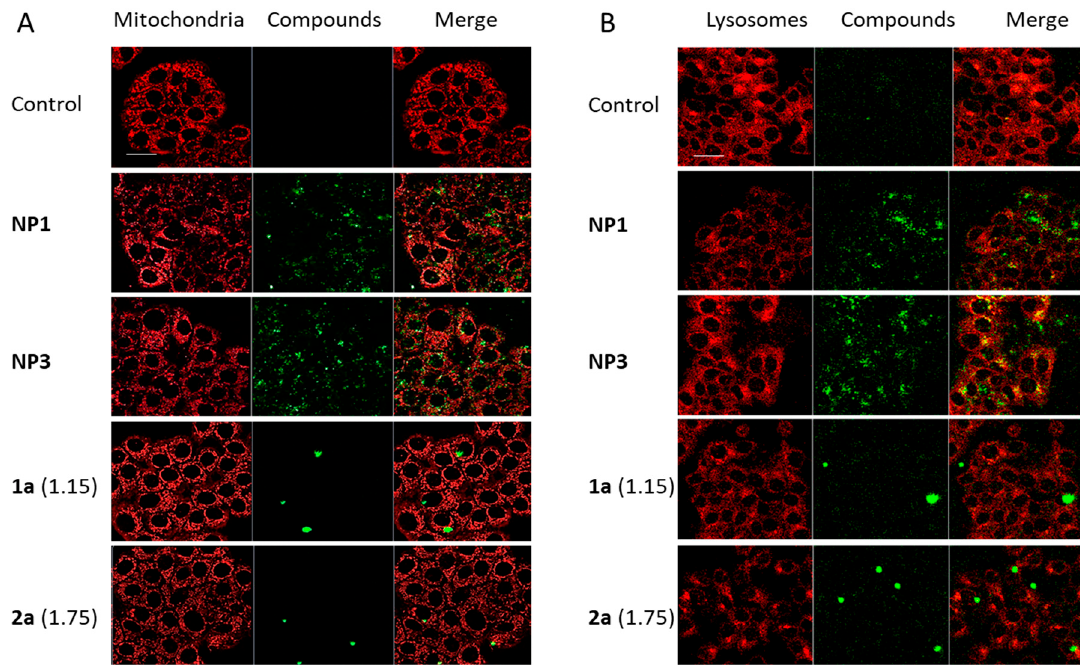
Figure 6. Colocalization experiments. MCF-7 breast cancer cells incubated for 20 h with NP1 and NP3 (25 µg·mL − 1 ) and with analogous TEG-ylated 1a and 2a at the same porphyrin concentrations. NPs and free porphyrins were excited with a Chameleon femtosecond laser ( λ ex = 790 nm) and appear here in green. Mitochondria ( A ) or lysosomes ( B ) were stained with MitoTracker ( λ ex = 490 nm) or LysoTracker ( λ ex = 577 nm), respectively and appear here in red. Scale bar: 10 µm. Finally, and in order to verify the possible use of such NPs with other cancer cells, their internalization was studied on highly aggressive cell lines such as MDA-MB-231 breast cancer (triple negative) and Capan-1 pancreas cancer cells. For this, confocal imaging was performed on cells incubated 20 h with NP1 and NP3 (25 µg·mL − 1 ) and equivalent concentration of TEG-ylated porphyrins 1a and 2a . Cell membranes were stained with CellMask . NP1 and NP3 were efficiently internalized in both cancer cell lines (Figure 7), showing a strong bioavailability at the contrary of their TEG-ylated porphyrins ( 1a and 2a ). This result suggests an efficient targeting potential of such NP for various cancer cells.